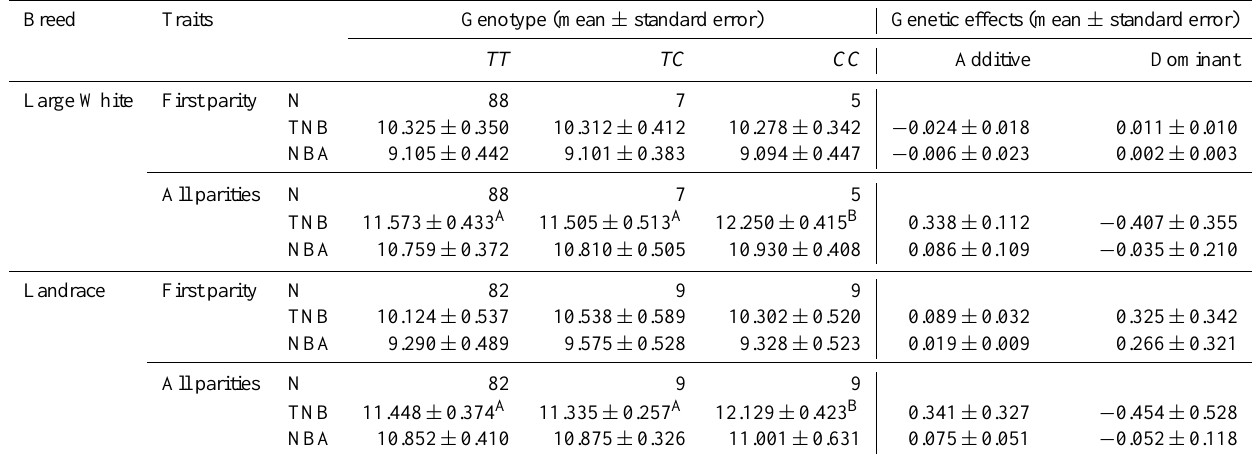
Table 3. Association analyses between PCR- Pst I-RFLP genotypes and litter size of the porcine SPATS2L gene. Breed